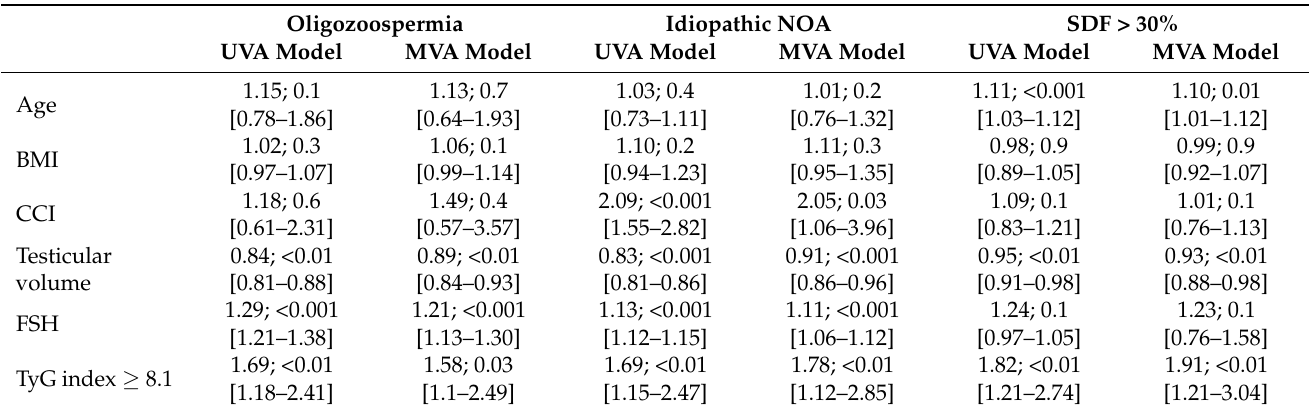
Table 4. Logistic regression models predicting oligozoospermia, idiopathic NOA and DFI > 30% (OR; p value [95% CI]) in the whole